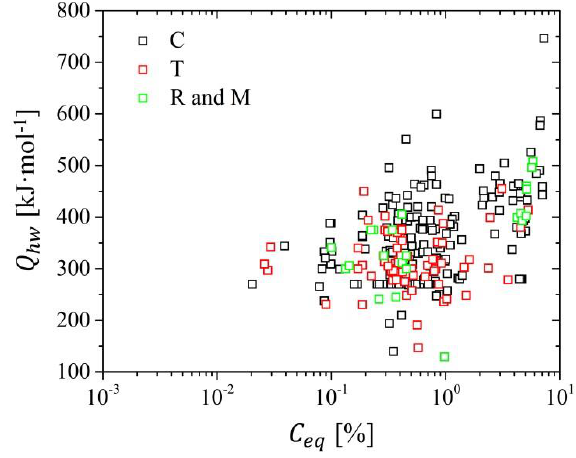
Figure 7. Activation energy vs. the carbon equivalent of the alloys ( C eq ) using Equation (36). Nearly 320 experimental data were analyzed, where approximately 65.0% of them correspond to compression data, 30.0% to torsion data, and the rest to multiple techniques and tension data. See Figure 8 and Table 1. The statistical analysis of data reveals a mean value of m approximately close to 0.152 with a standard deviation of 0.07 and minimum and maximum values of 0.08 and